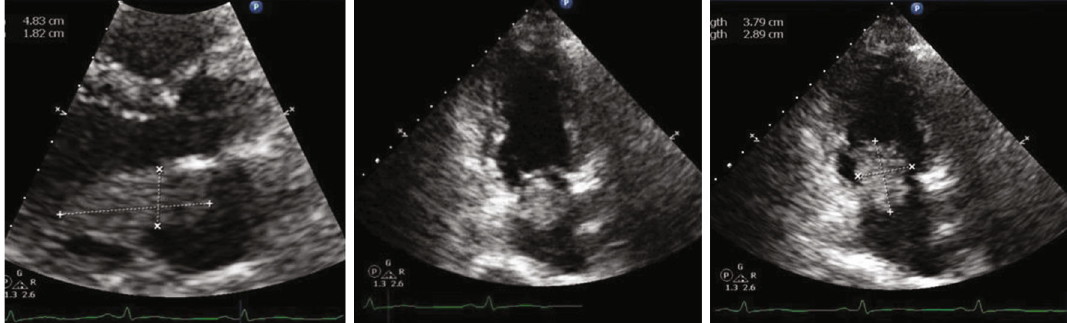
Figure 2: Transthoracic echocardiogram. There is a large, 5 : 7 cm ð L Þ × 1 : 9 cm ð W Þ , mobile mass on the left side of the interatrial septum; the appearance is consistent with myxoma (echocardiographic contrast reveals vascularity of the mass). The mass travels along with the anterior mitral lea fl et and plops in and out of the left ventricle. Transvalvular velocity of the mitral valve is within the normal range, and there is no evidence of stenosis. Left ventricular ejection fraction was in the range of 55% to